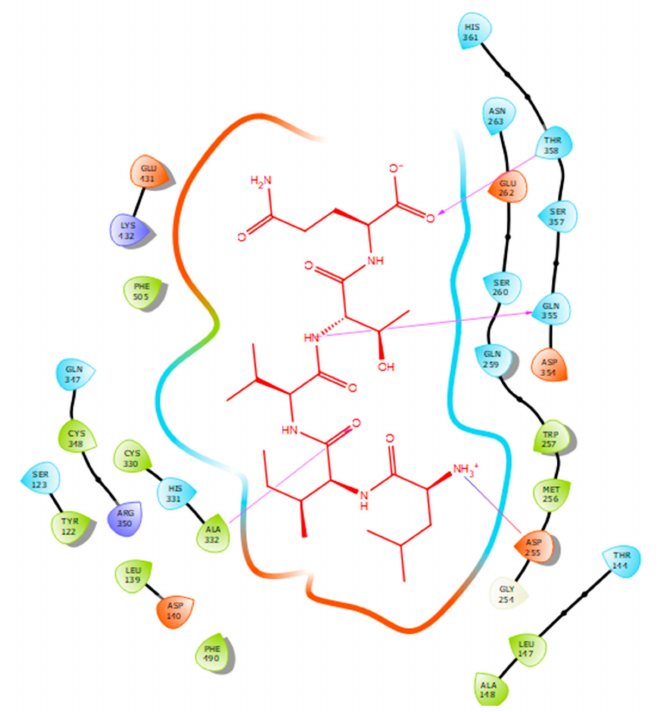
Figure 4. Docking results of the peptide LIVTQ in the human ACE active site. LIVTQ is represented in red, the interactions of human ACE residues with the peptide are indicated by arrows of di ff erent colours with purple representing hydrogen bond interactions, and blue arrows representing salt bridge interactions. The software Maestro was used for the generation of this